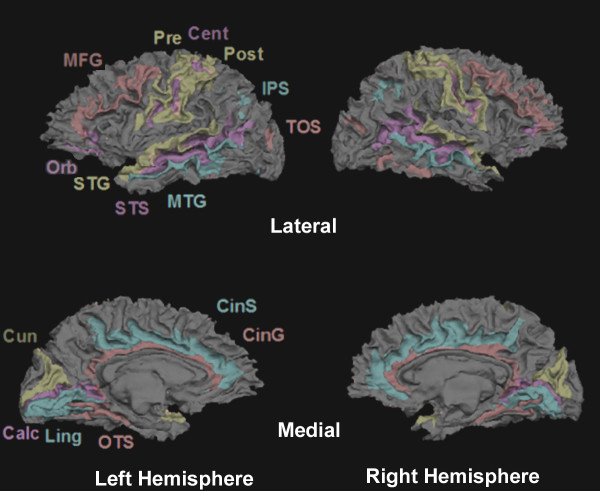
Co-registration of the TBI patient's cortical surface anatomy with the Freesurfer atlas. An accurate parcellation of the cortical surface was produced by Freesurfer shown superimposed on the semi-inflated surface of the patient (sulci = dark, gyri light). Cortical regions are accurately labeled. Anatomical labels: Calc, calcarine sulcus; Cent, central sulcus; CinG, cingulate gyrus; CinS, cingulate sulcus; Cun, cuneus; IPS, interparietal sulcus; Ling, lingual gyrus; MFG, medial frontal gyrus; MTG, medial temporal gyrus; Pre, precentral gyrus; Post, postcentral gyrus; Orb, orbital sulcus; OTS, occipito-temporal sulcus; STG, superior temporal gyrus; STS, superior temporal sulcus; TOS, transverse occipital sulcus.